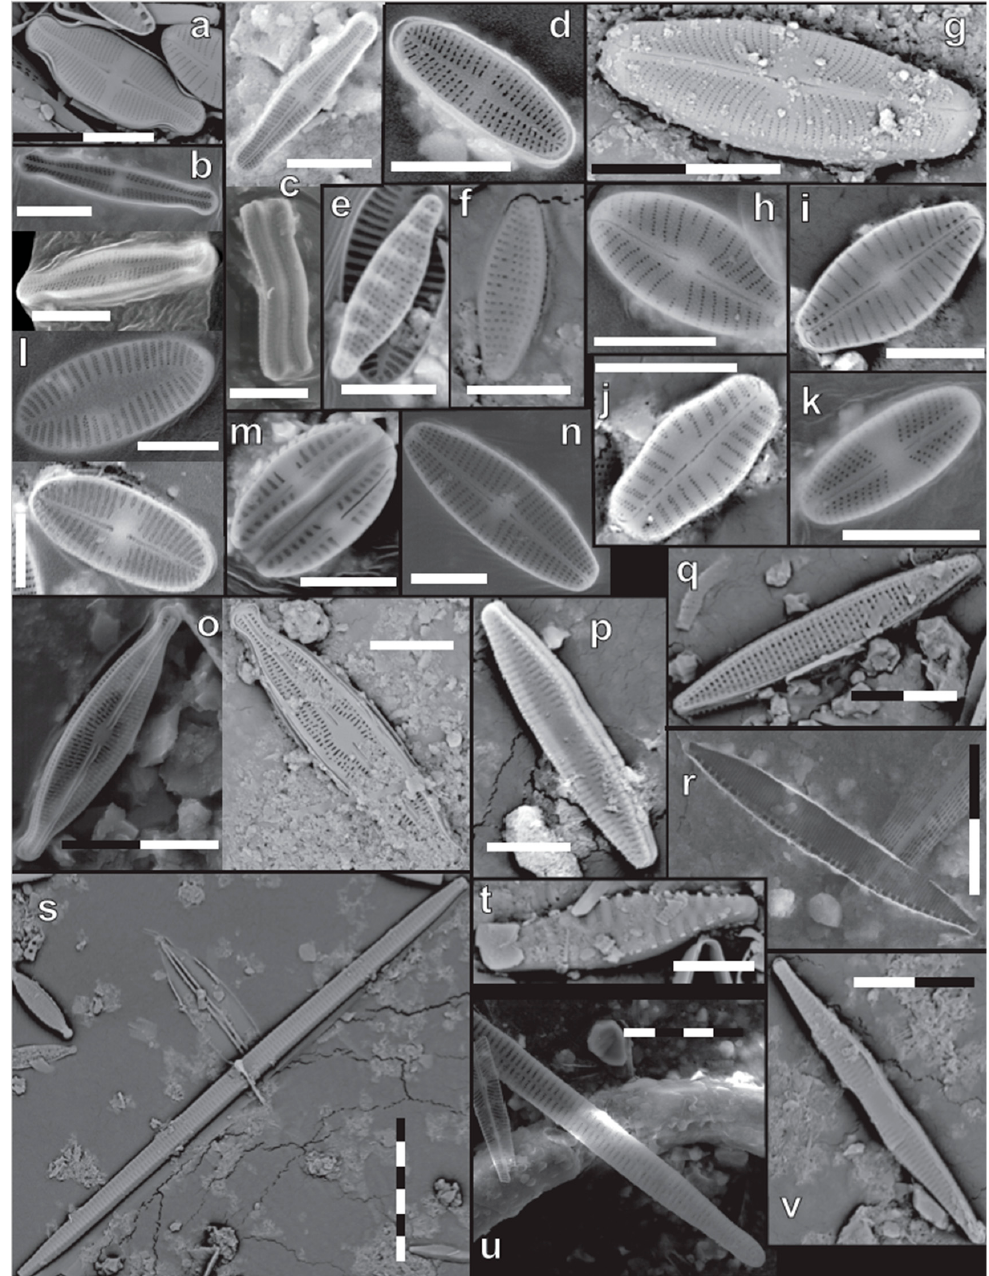
Figure 3. SEM photographs of some of the most common diatoms found in the water bodies. Each black or white part of the scale bar is 5 µm. Identifications: ( a ) Achnanthidium exiguum (Grunow) Czarnecki (raphe valve); ( b ) Achnanthidium macrocephalum (Hustedt) Round & Bukhtiyarova (raphe and rapheless valve); ( c ) Achnanthidium minitissimum (Kützing) Czarnecki (raphe valve and girdle view); ( d ) Achnanthidium saprophilum (H.Kobayashi & Mayama) Round & Bukhtiyarova (rapheless valve); ( e ) Grunowia solgensis (A.Cleve) Aboal; ( f ) Nitzschia frustulum (Kützing) Grunow; ( g ) Sellaphora pupula (Kützing) Mereschkovsky; ( h ) Sellaphora cf. nigri (De Notaris) Wetzel & Ector; ( i ) Geissleria sp. 2 Lange-Bertalot & Metzeltin; ( j ) Sellaphora cf. saugerresii (Desmazières) C.E.Wetzel & D.G.Mann; ( k ) Sellaphora cf. atomoides (Grunow) Wetzel & Van de Vijver; ( l ) Platessa hustedtii (Krasske) Lange-Bertalot (raphe and rapheless valve); ( m ) Amphora pediculus (Kützing) Grunow; ( n ) Geissleria sp. 1 Lange-Bertalot & Metzeltin; ( o ) Brachysira neoexilis Lange-Bertalot; ( p ) Fragilaria capucina Desmazières; ( q ) Nitzschia amphibia Grunow; ( r ) Nitzschia cf. palea (Kützing) W.Smith; ( s ) Ulnaria cf. unlabiseriata D.M.Williams & B.Liu; ( t ) Punctastriata cf. mimetica E.A.Morales; ( u ) Ulnaria cf. biceps (Kützing) Compère; ( v ) Ulnaria cf. contracta (Østrup) E.A.Morales & M.L.Vis.